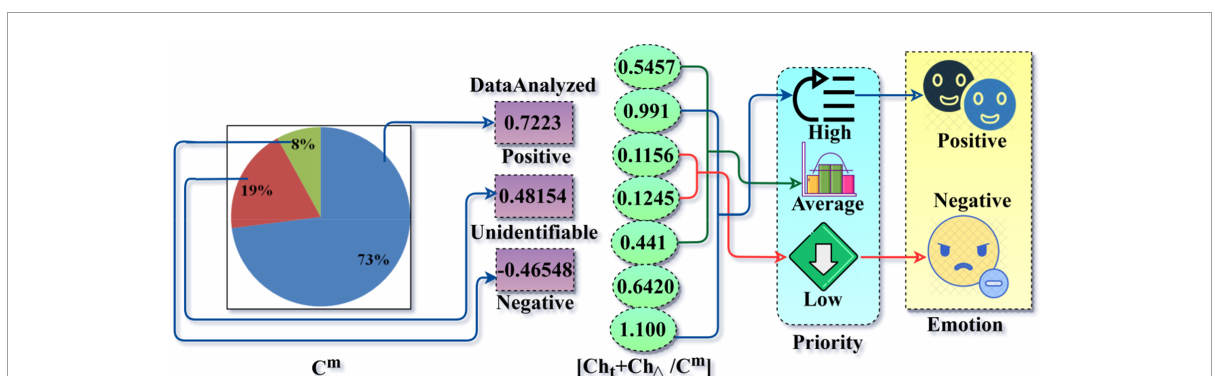
balanced by using the deep learning to reduce the C m density; the unidentifiable C m is reduced from the P S ∀ α .